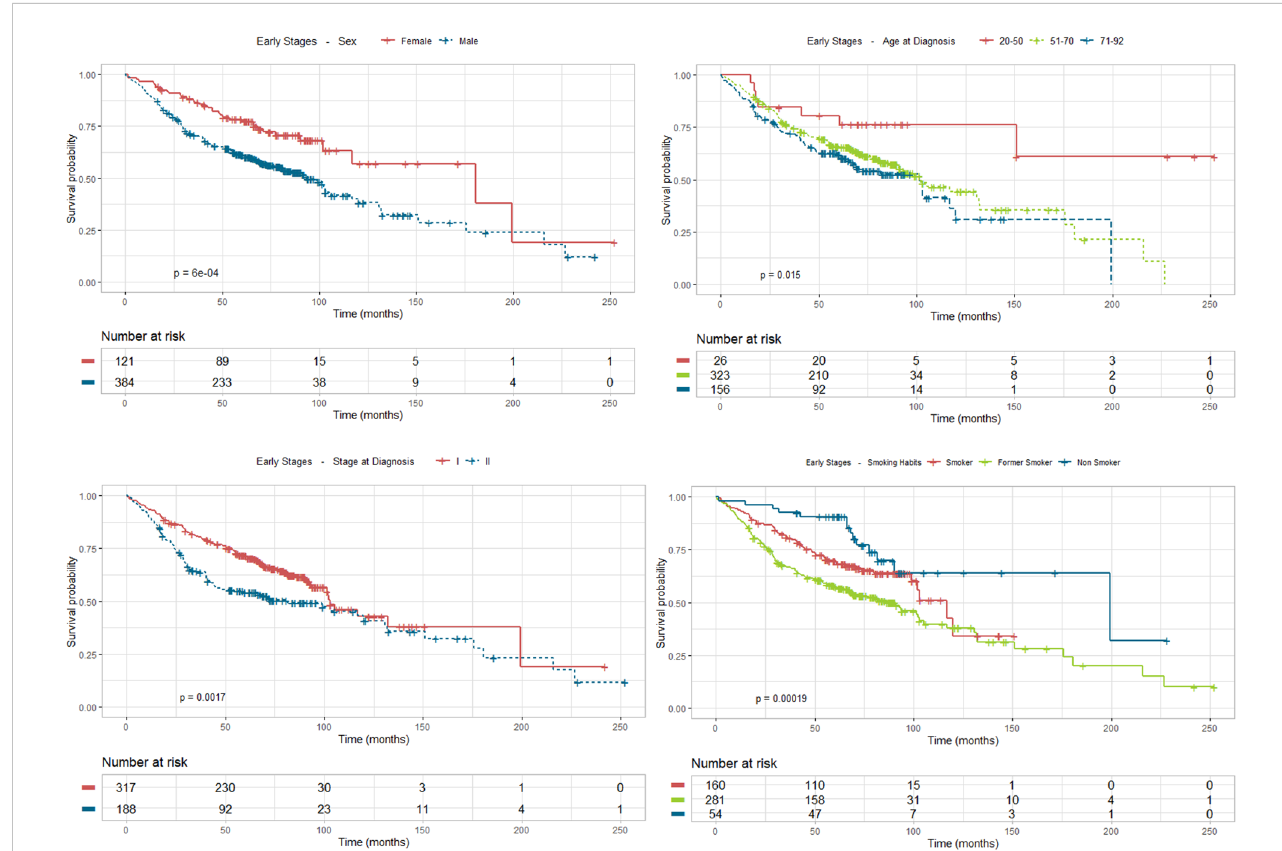
FIGURE 4 Survival analysis using Kaplan Meier estimates in stages I and II according to sex, age at diagnosis, stage and smoking